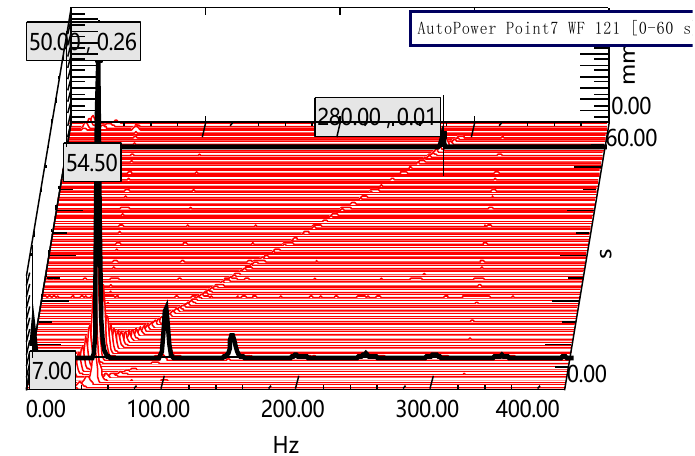
Figure 19. Sweeping frequency waterfall.